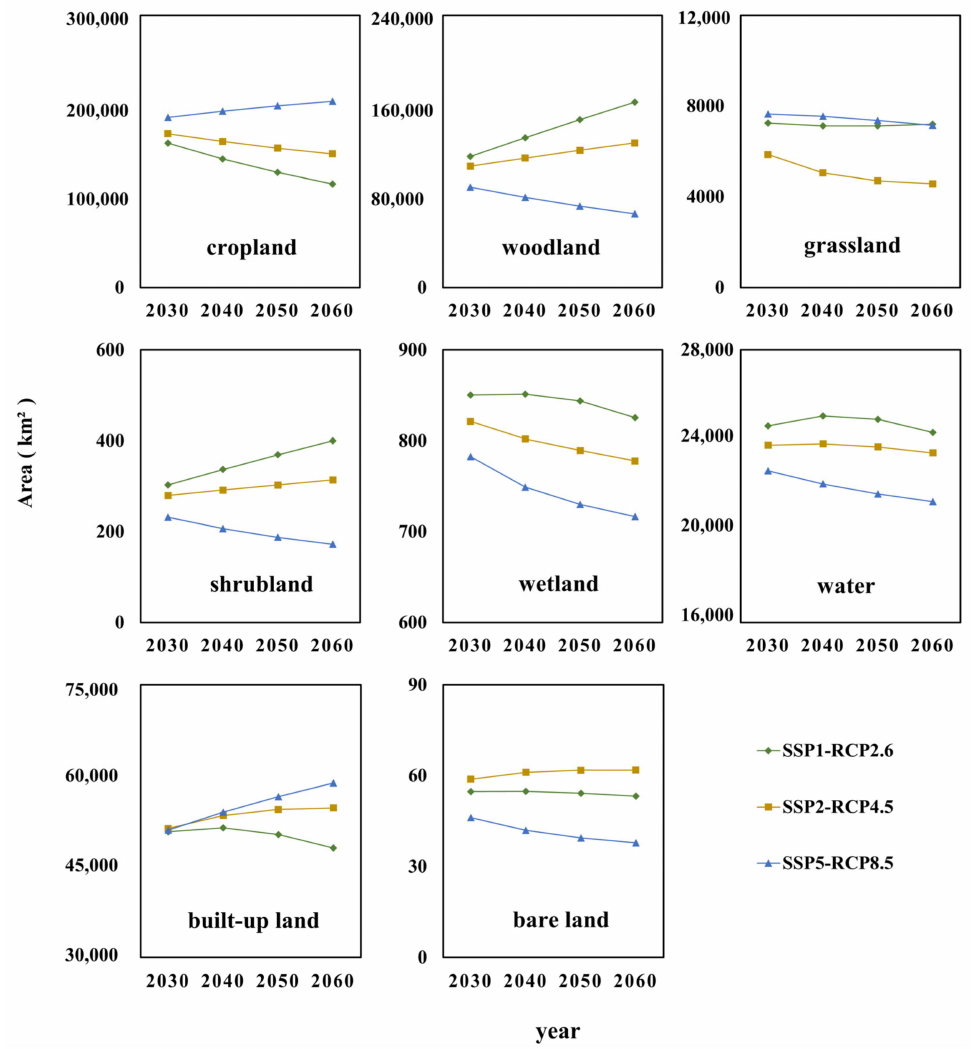
Figure 7. Forecast of land use area under different scenarios in the Yangtze River Delta of 2030, 2040, 2050, 2060.